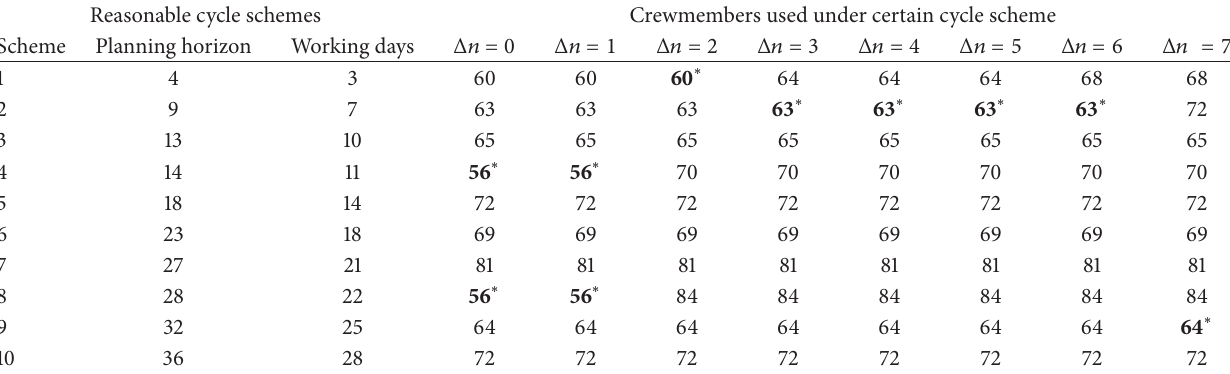
Table 3: Optimal cycle schemes with different Δ𝑛 .